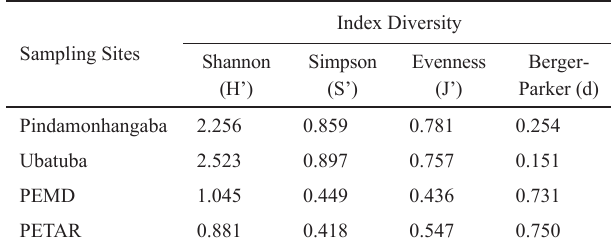
Table 2. Shannon’s diversity (H’), Simpson’s diversity (S’), Pielou’s evenness (J’ ) and Berger-Parker dominance (d) for the four study areas.